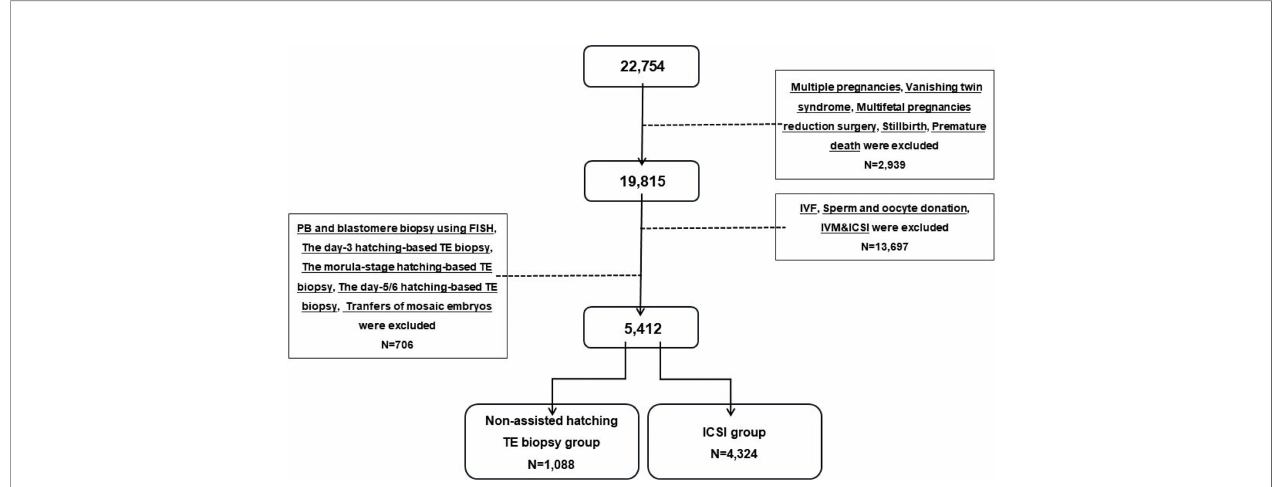
FIGURE 1 | Flowchart of the study populations. IVF, in-vitro fertilization; ICSI, intracytoplasmic sperm injection; IVM, in-vitro maturation; PB, polar body; TE,